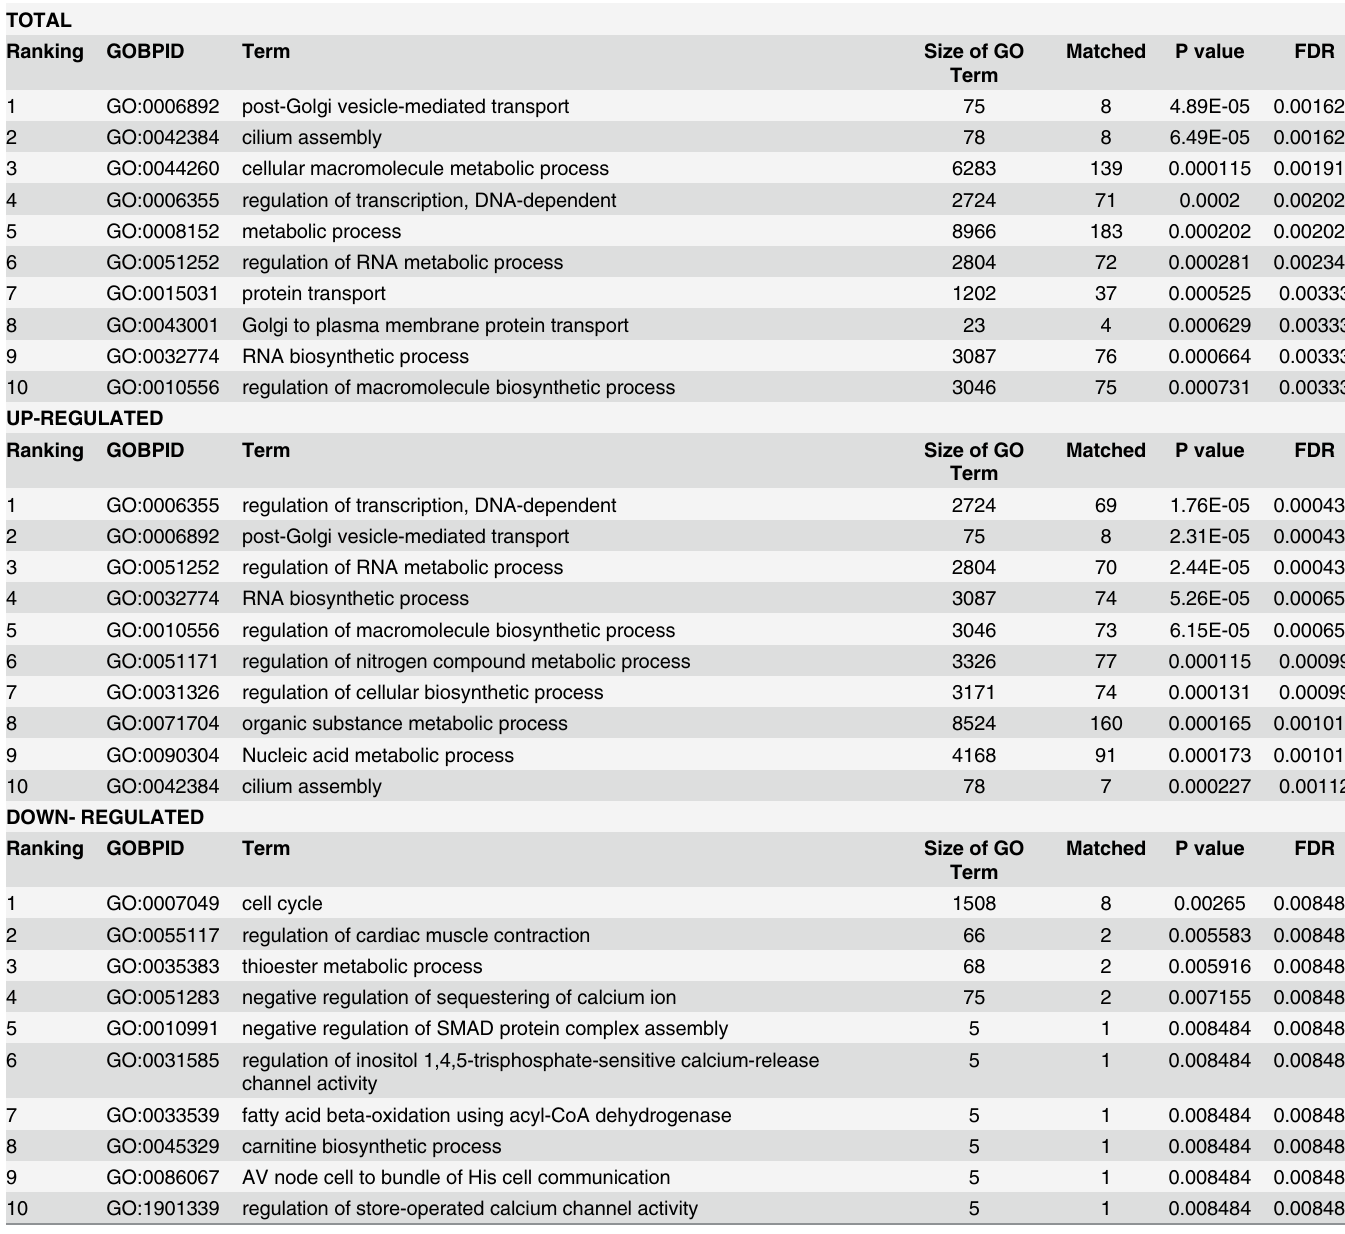
Table 2. TOP 10 list of GO pathway analysis of DEGs between BPD and control in L